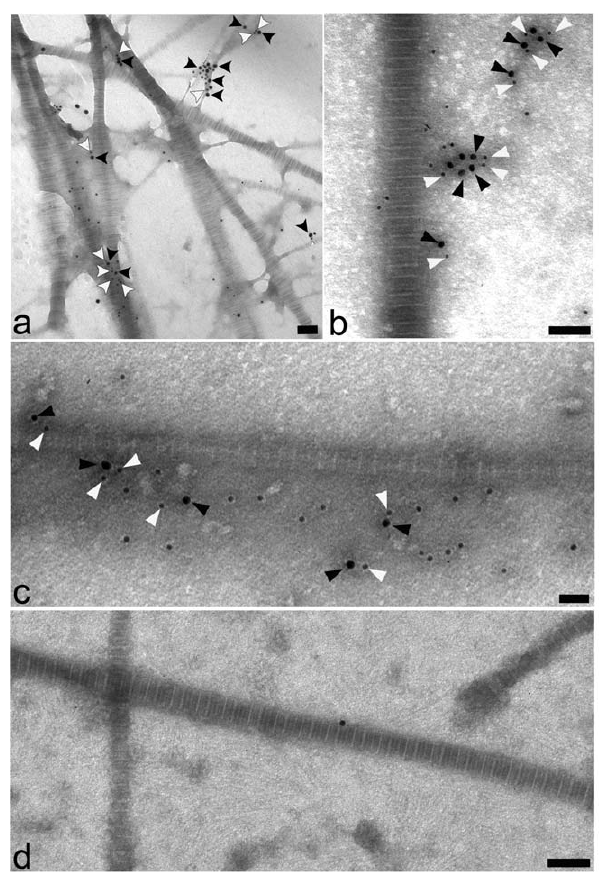
Figure 2. Localization of WARP and collagen VI using electron microscopy. EM analysis on native supramolecular fragments isolated from human articular cartilage. Sheep antisera against WARP (18-nm gold particles; black arrow heads) (panels a–c) and a rabbit polyclonal anti-collagen VI (panels a and b) or monoclonal antibody against collagen VI (panel c) (12-nm gold particles; white arrowheads) was used. A secondary antibodies only control is shown in panel d. Scale bars: 100 nm.